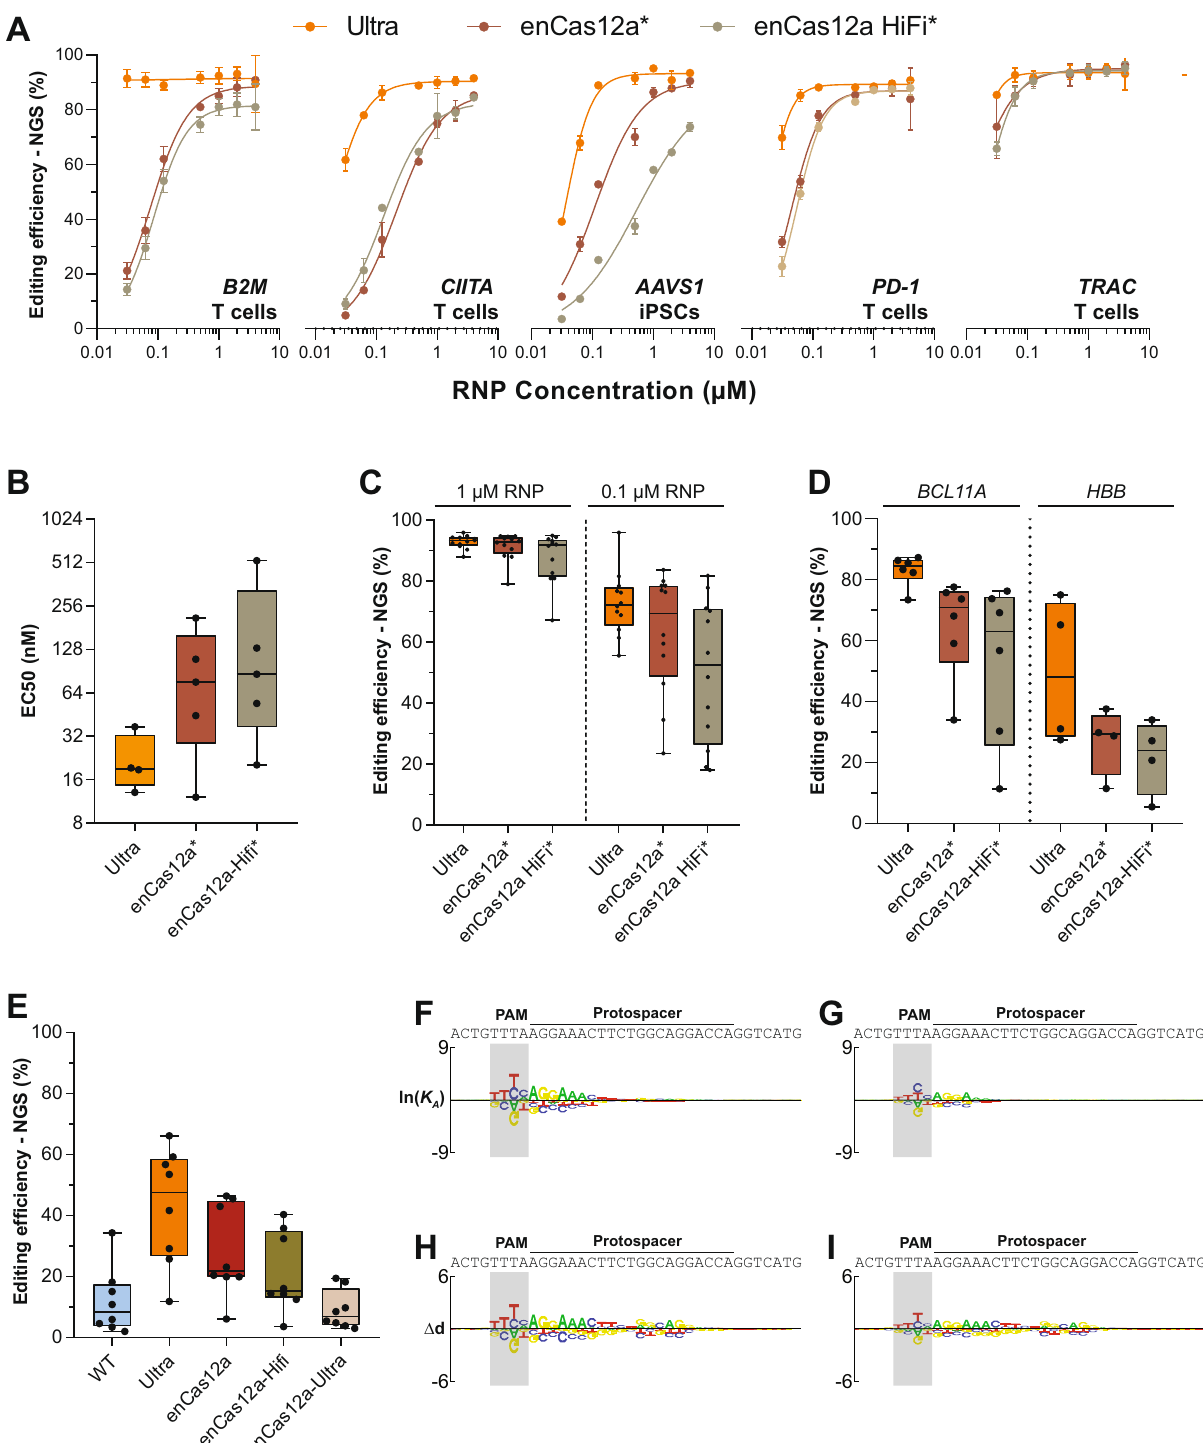
highly ef fi cient editing (EC50: 5.2 nM) of TGFBR2 across three